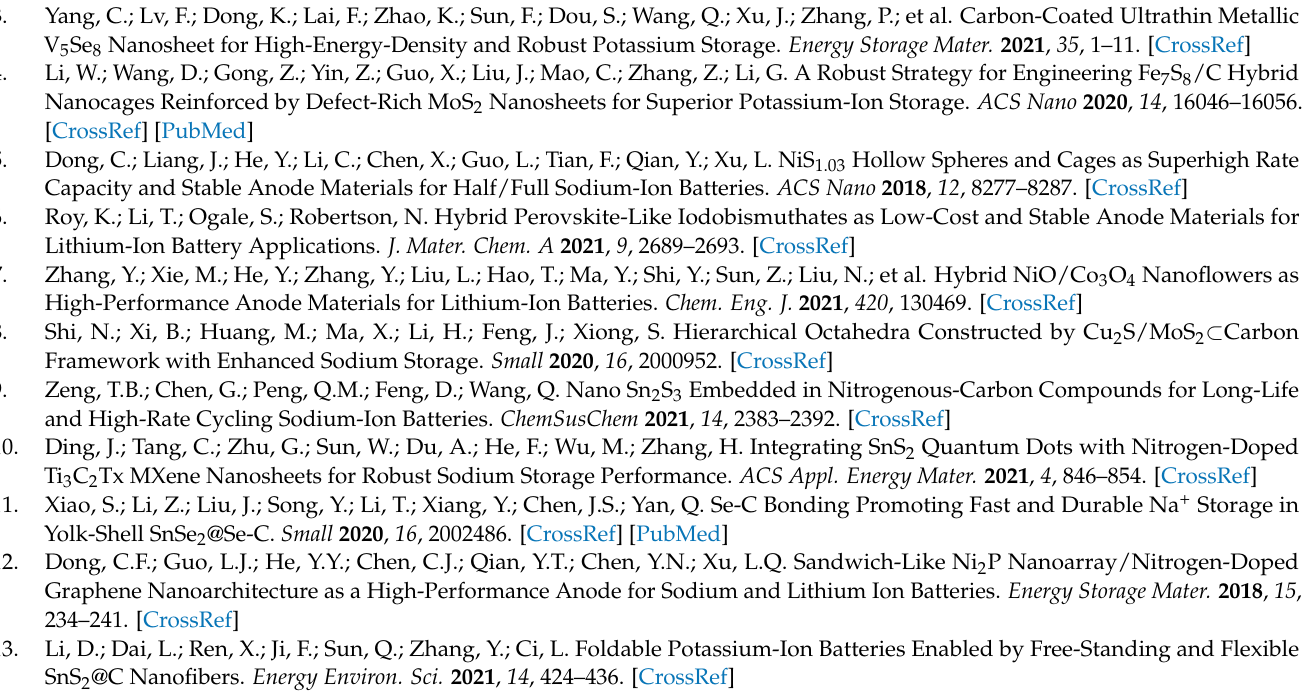
conditions. (a) In the presence of GO but without 2-MIN. (b) In the presence of 2-MIN but without GO. (c) In the absence of 2-MIN and GO, Figure S2: (a) FESEM image of SnS 2 . (b) FESEM image of SnS 2 and the corresponding elemental mappings of Sn and S elements (as labeled), Figure S3: (a) Nitrogen adsorption-desorption curve of SnS 2 /RGO, (b) the related pore size distribution curve, Figure S4: High resolution XPS spectrum of SnS 2 , Figure S5: (a) Cyclic voltammetry (CV) curves of SnS 2 /RGO. (b) FEEM image of SnS 2 /RGO electrode after rate performance. (c) CV profiles of SnS 2 at different sweep rates. (d) Linear relationship of log (i) vs. log (v) plots at each redox peak. (e) CV curve with capacitive and diffusion-controlled contributions at 0.6 mV s -1 , in which the pseudocapacitive fraction is shown in the pink region, Figure S6: (a) Voltage versus time curve for one single GITT test. (b) The plots of voltage vs. root of pulse time ( τ 1/2 ), Figure S7: CV curves of the SnS 2 /RGO electrode at a scan rate of 0.1 mV s -1 for the first four cycles for PIBs, Figure S8: (a) The charge/discharge curves of SnS 2 /RGO electrode obtained during GITT measurement, (b) a single GITT titration curve during the charge process, and (c) the plots of voltage vs. root of pulse time ( τ 1/2 ), Figure S9: (a) The cycling performance of SnS 2 /RGO at 0.6 A g -1 . (b) Rate performance of SnS 2 /RGO electrode at various densities of 0.2–2.0 A g -1 , Table S1: Electrochemical performance comparisons of SnS 2 /RGO electrode with those of the previously reported transition metal dichalcogenides anodes for